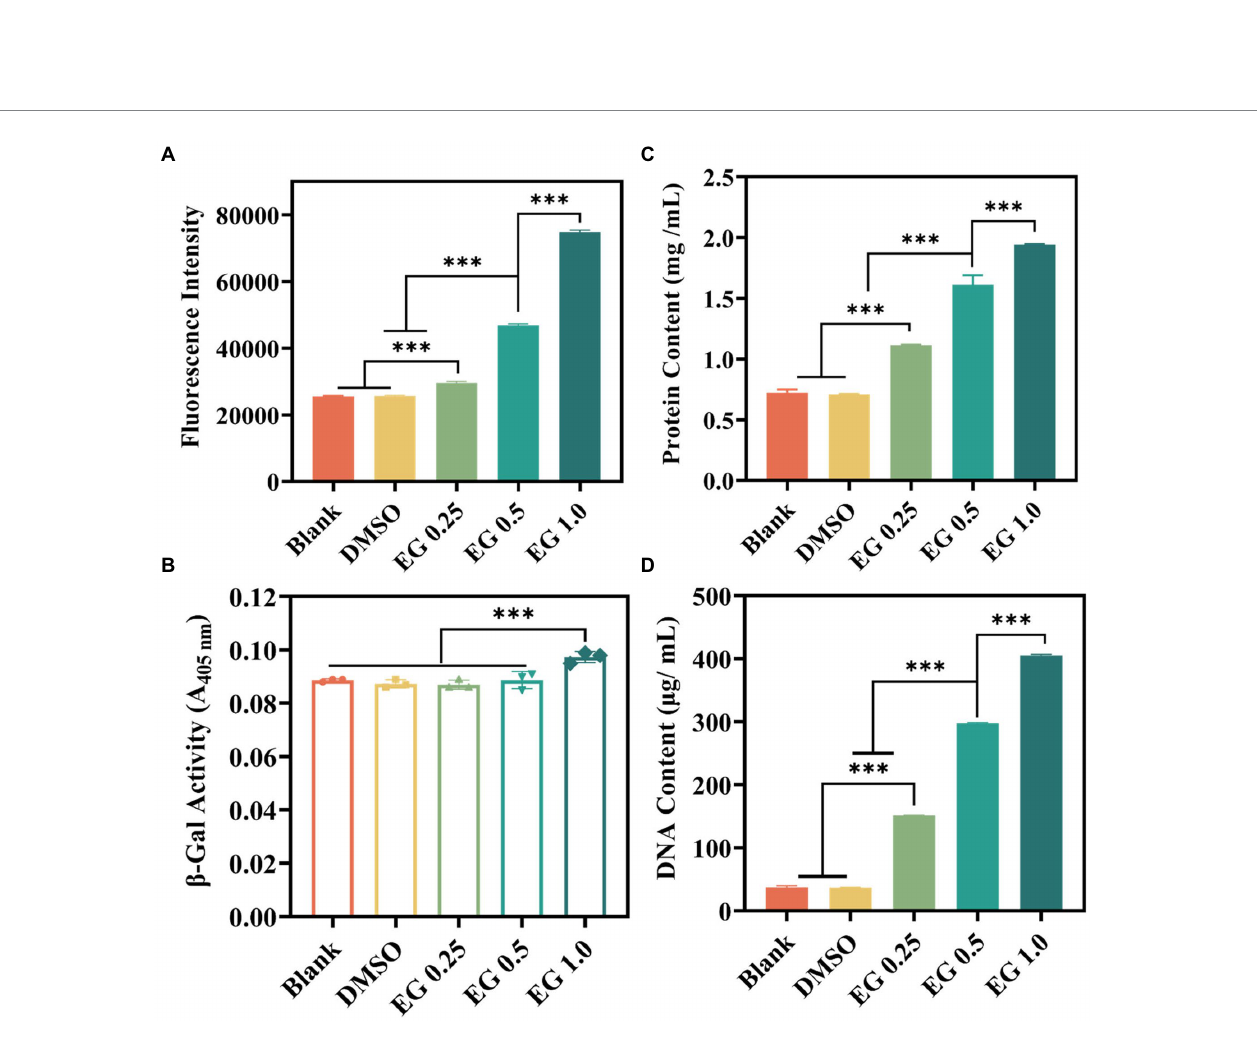
FIGURE 5 (A) Intracellular reactive oxygen species (ROS) generation of CRKP after treatment with EG for 24 h. (B) β -galactosidase leakage from the destroyed bacterial membrane by monitoring the value of A405 nm. (C) Total leaky proteins assessment of bacteria in the different groups. (D) DNA leakage content of the diverse groups. Data are mean ± SD ( n = 3; *** p <